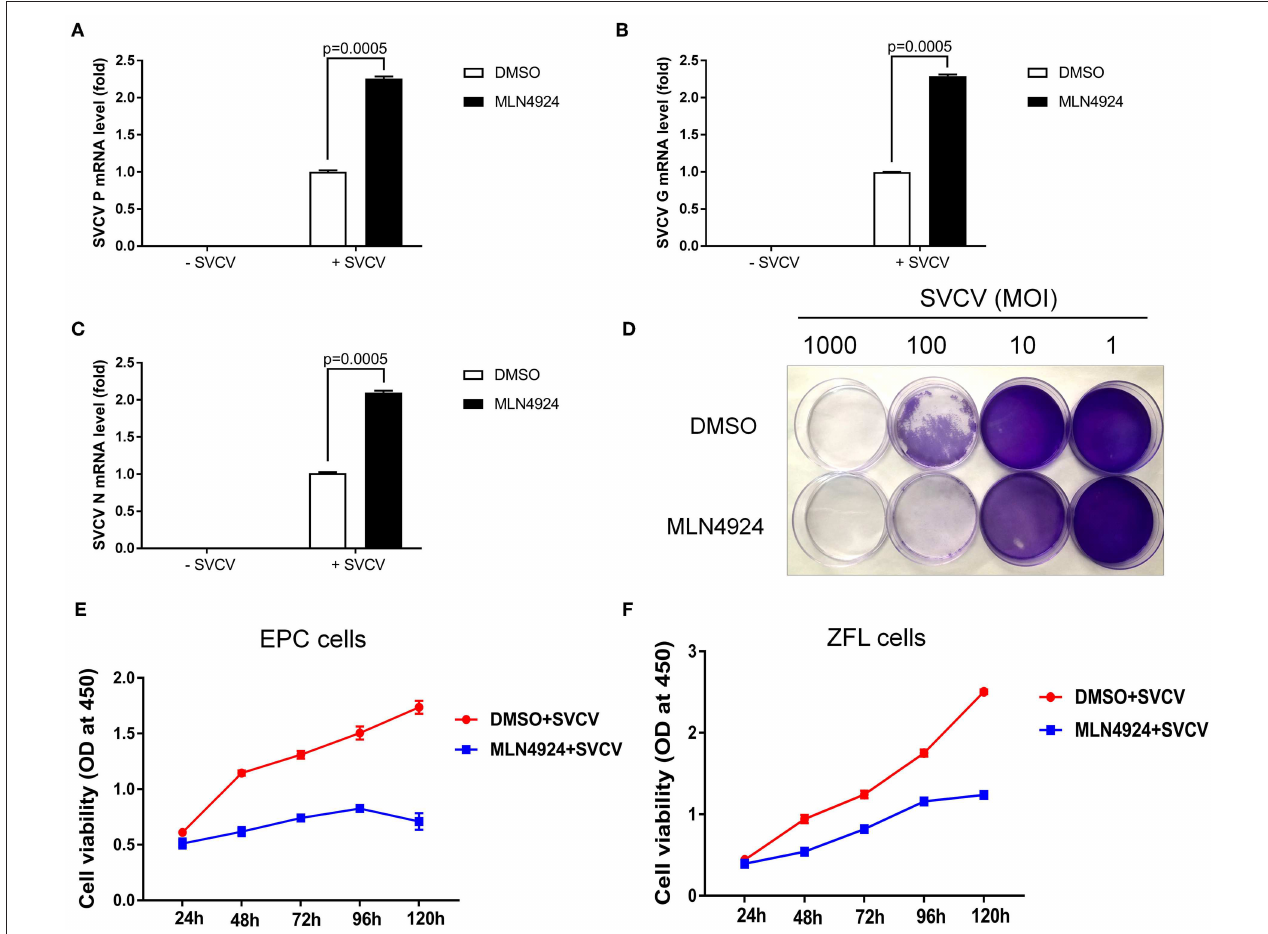
FIGURE 3 | MLN4924 increases SVCV replication in EPC cells. (A–C) In EPC cells, MLN4924 treatment after SVCV infection increased the copy number of SVCV-related genes, as compared to vehicle (DMSO)-treated cells. We treated EPC cells with either vehicle (DMSO) or MLN4924 (1 µ M) for 24h, and then infected the cells with SVCV (MOI of 10). After SVCV infection for 24h, we extracted total RNA and used quantitative real-time PCR (qPCR) assays to determine the mRNA expression levels of the SVCV P , G , and N genes. (D) Treatment with 1 µ M MLN4924 after SVCV infection reduced survival in EPC cells. (E,F) In EPC cells (E) and ZFL cells (F) , MLN4924 treatment after SVCV infection inhibited cell proliferation. We treated EPC cells or ZFL cells with either vehicle (DMSO) or MLN4924 (1 µ M) for 24h, and then infected the cells with SVCV (MOI of 10) for 24h. Cell viability was determined using the Cell Counting Kits at the indicated time points. Data are